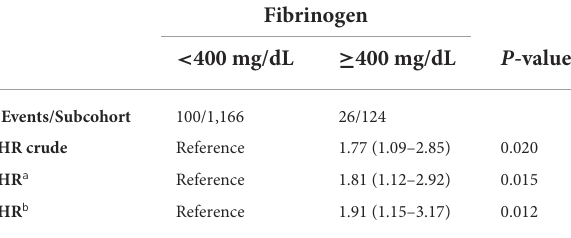
TABLE 2 HR (95% confidence interval) for developing colorectal cancer according to levels of fibrinogen < or ≥ 400